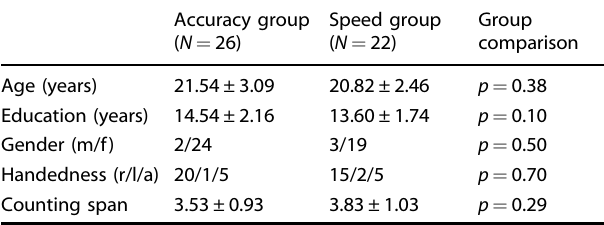
Table 1. Characteristics of the two experimental